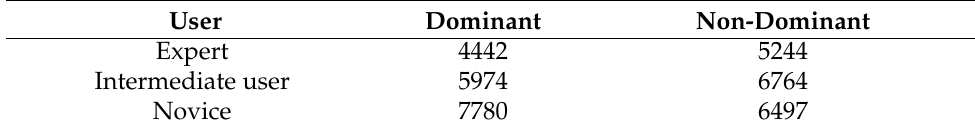
Table 3. Number of grip force signals for each